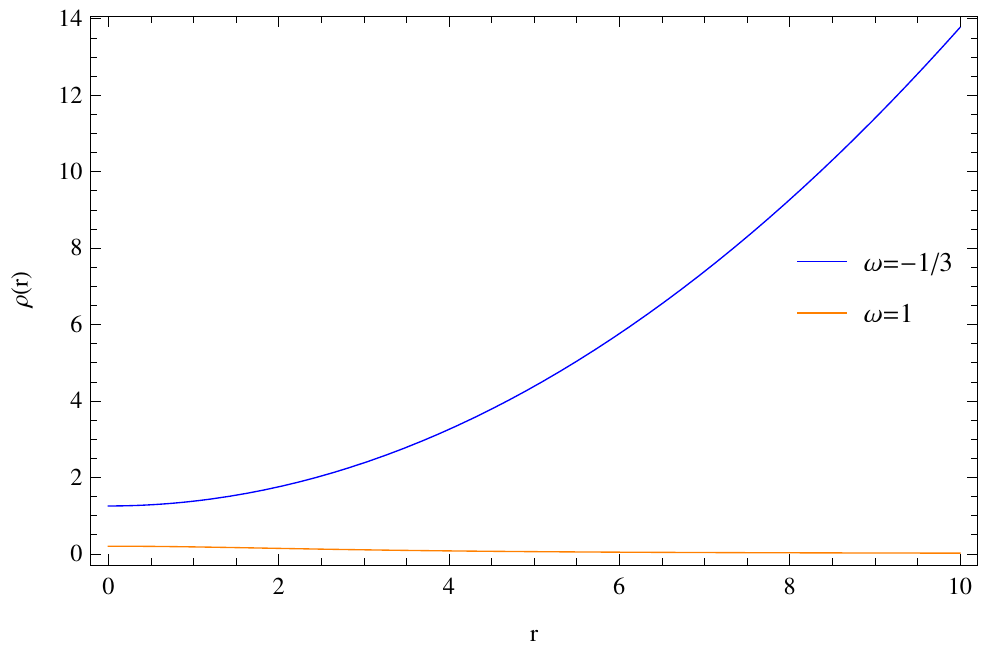
Figure 19. The density is plotted against the radial parameter r with the values of arbitrary constants C 3 = 2, C 4 = 0.001, C 5 = 10.